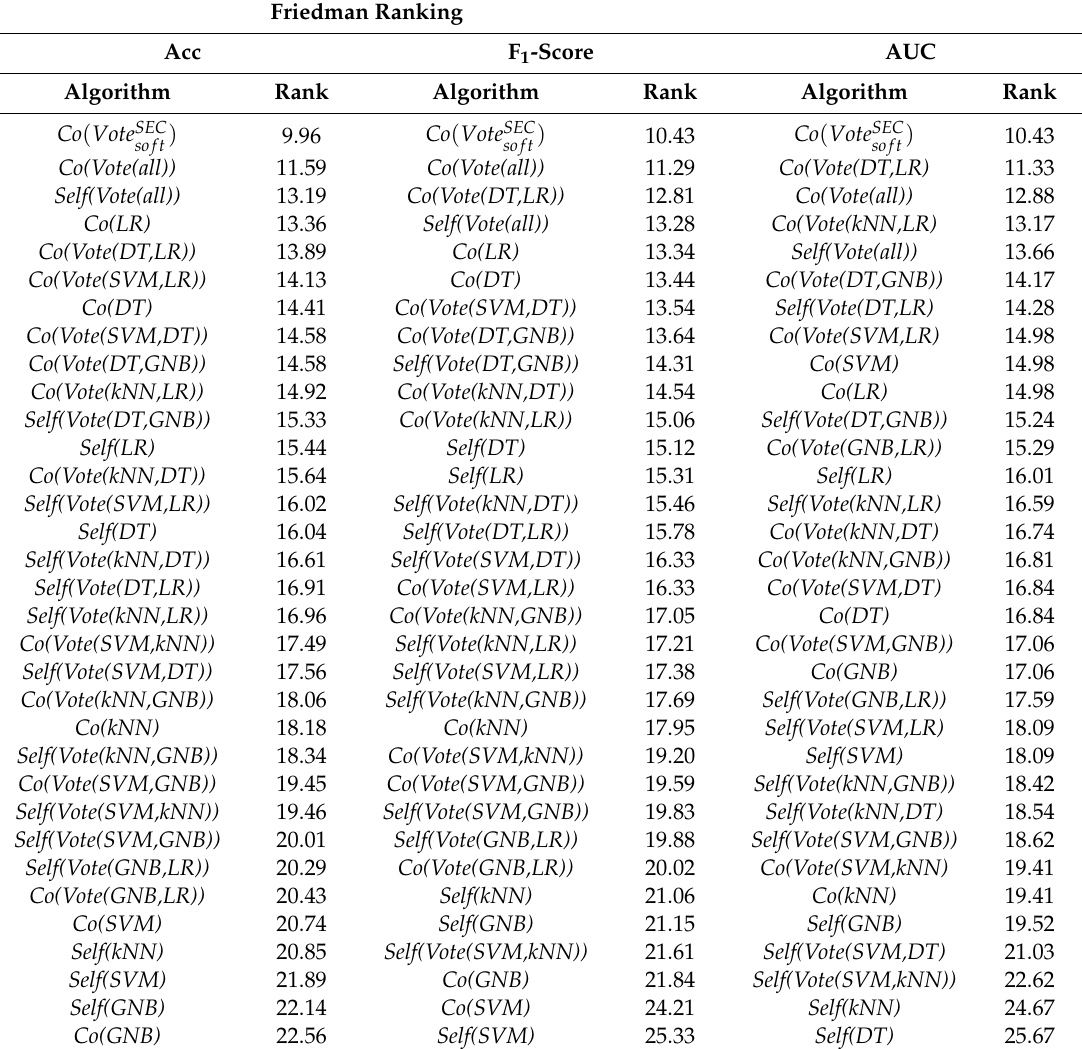
Table 6. Friedman Rankings for all examined algorithms and statistical importance based on Nemenyi post-hoc